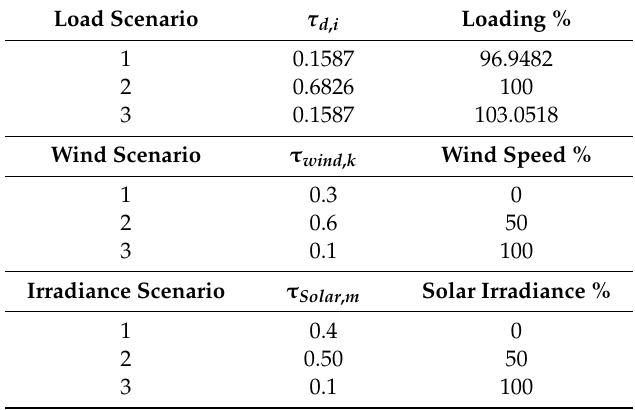
Figure 1. The load probability density function (PDF) and load uncertainty scenarios generation. Table 1. Load, wind and solar irradiance scenarios with the corresponding probabilities.